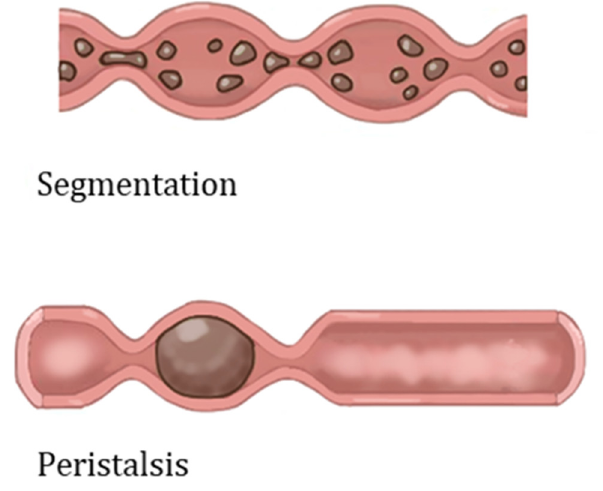
Figure 3. The schematic of peristaltic and segmentation contractions of the GI tract [27]. Another unique characteristic of the human gut is the steep oxygen gradient, whereby different regions of the GI tract reflect different partial pressures (pO 2 ). Interestingly, under normal conditions, it is understood that the intestinal epithelium exists in a state known